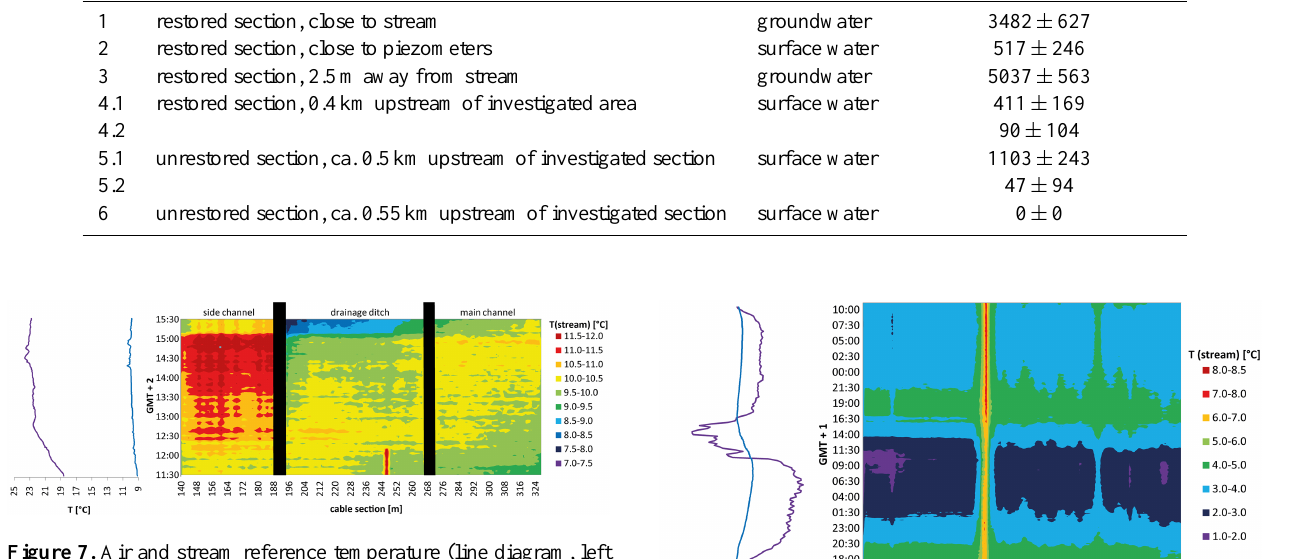
Figure 7. Air and stream reference temperature (line diagram, left side; purple and blue line, respectively) and surface water tempera- tures (colour plot, right side) of the Urbach on 3 September 2013. The x axis of the colour plot shows the sections of the fibre-optic ca- ble in metres; the colours represent the surface water temperatures in ◦ C. Thereby, each coloured line on the x axis, from cable section 140 to 327m, represents one measurement. The y axis states the time of the measurements.